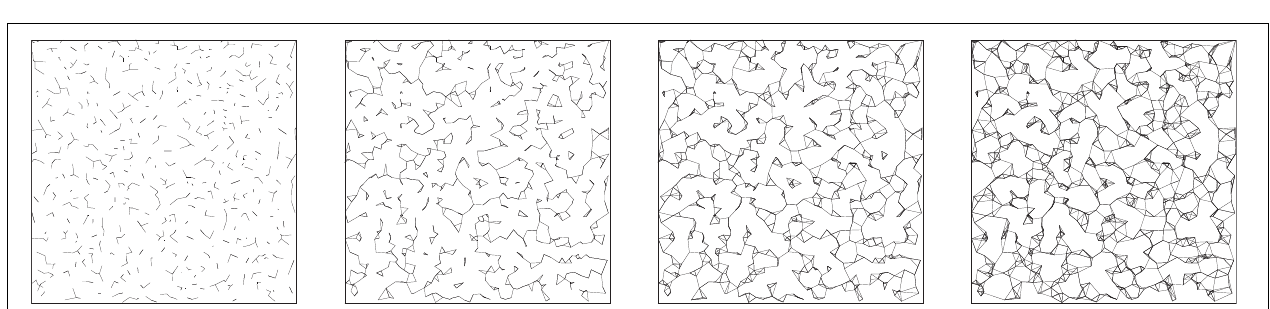
the interaction zone are shown using red arrows. (B) In the next time step the velocity of agent 0 is calculated by Equation (1) which is along the resultant of all n + 1 velocity vectors and has the magnitude v .